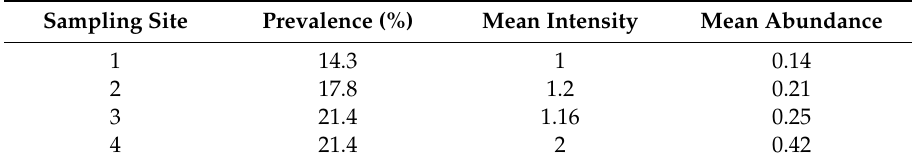
Table 2. Sampling site, prevalence, mean intensity, and mean abundance of infestation. Sampling